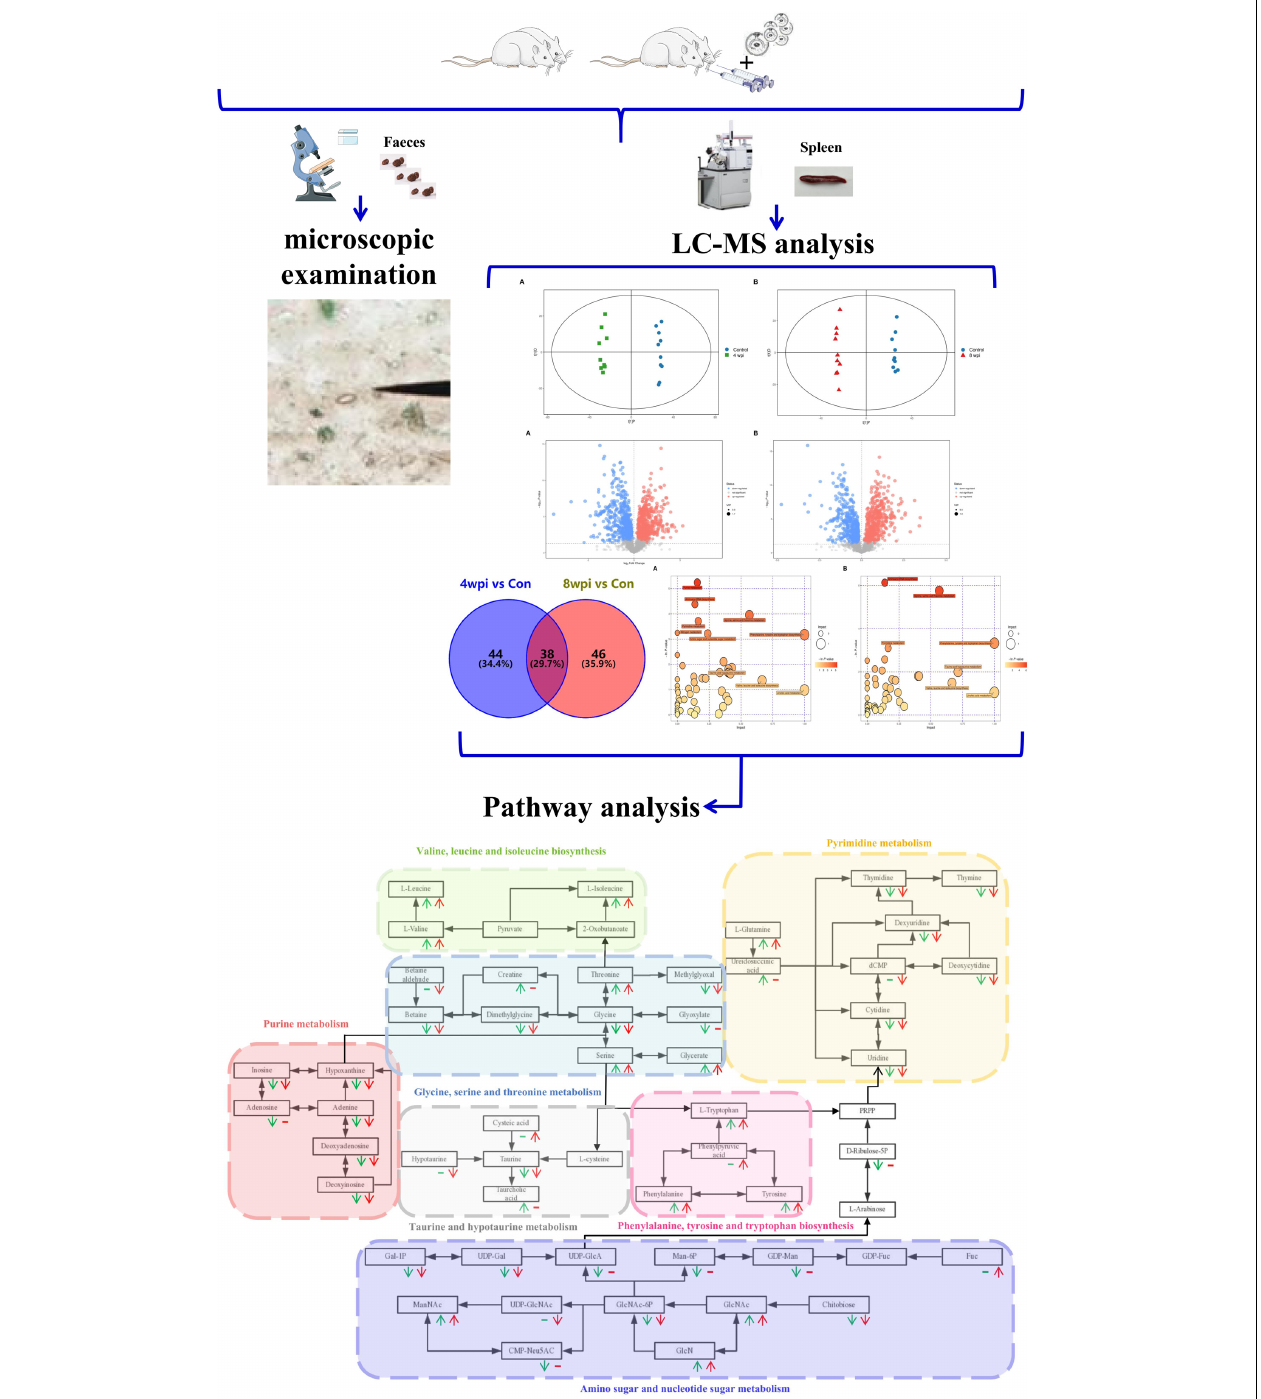
FIGURE 9 | Flow chart of metabolomics in spleen of rats infected with Clonorchis